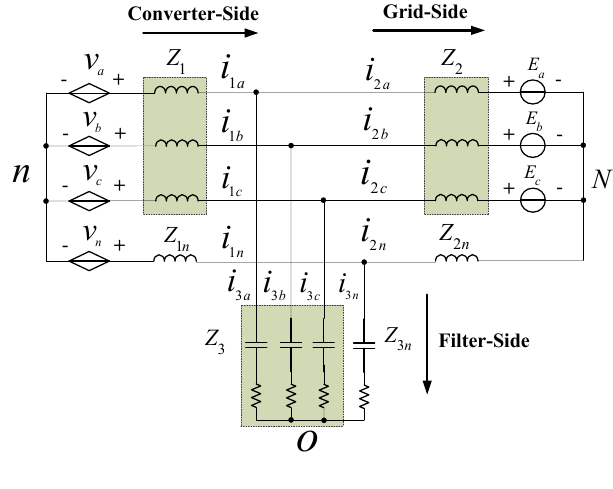
Figure 3. Equivalent circuit.